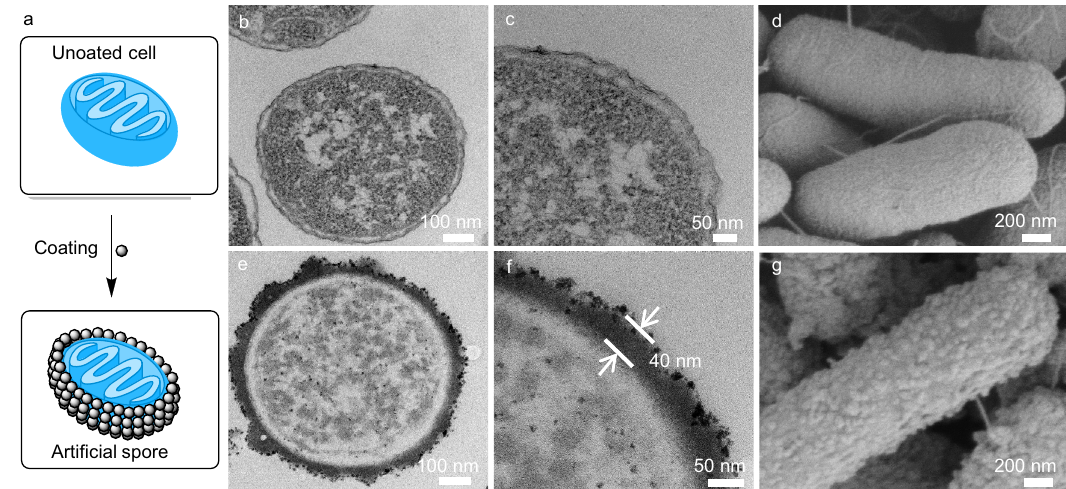
Fig. 2 Characterization of arti fi cial spores. a Scheme of the arti fi cial sporulation on an E. coli cell. Cross-sectional bright- fi eld transmission electron microscopy (TEM) images of ( b , c ) a native E. coli cell at different magni fi cations, as well as ( e , f ) an arti fi cial spore at different magni fi cations. Scanning electron microscopy (SEM) images of ( d ) native E. coli cells and ( g ) arti fi cial